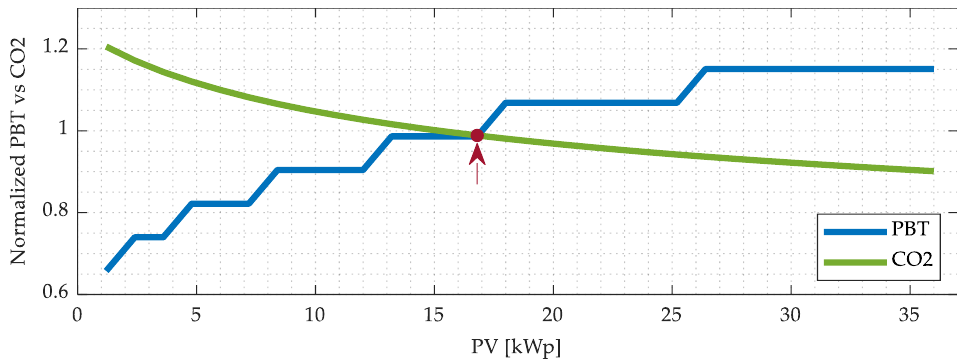
Figure 4. Normalized PBT vs. total CO 2 emissions for Scenario 2.